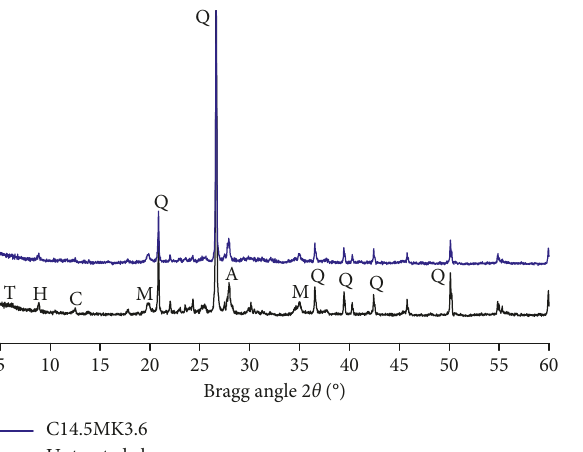
Figure 8: XRD patterns of cement-treated JX clay mixture with 20% MK replacement and untreated soil (Q, quartz PDF#86-2237; A, albite low PDF#72-1245; T, tosudite PDF#22-0956; H, halloysite PDF#29-1489; C, clinochlore PDF#83-1365; M, muscovite PDF#87-0691).